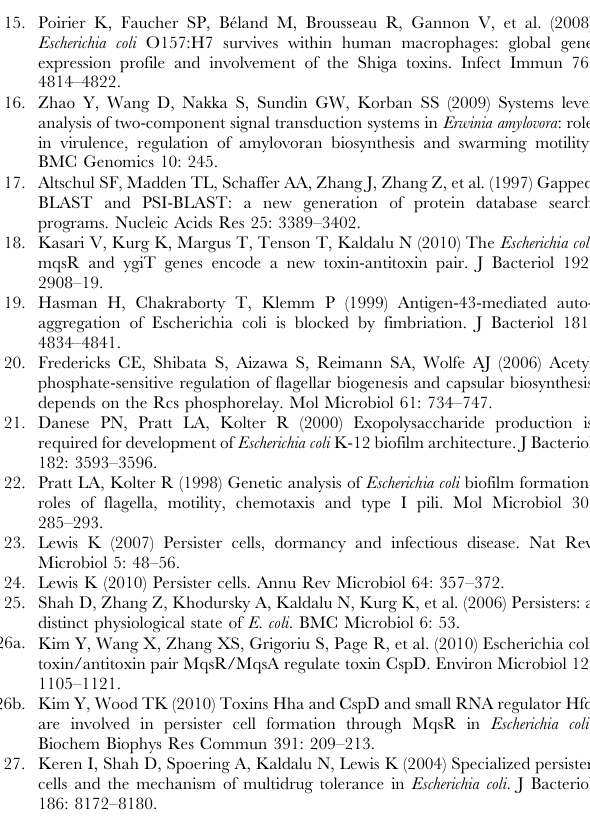
Figure S1 Gene context and protein conservation of ybjN in E. coli , E. amylovora and other related enteric bacteria. Indicate the accession number in GenBank and bacterial strains. Figure S2 Amino acid sequence alignments of YbjN homologs from seven enterobacterial strains. Deduced amino acid sequences have been obtained from NCBI and aligned by ClustalW program (www.ebi.ac.uk/Tools/clustalw2). Identical residues (*), conserved ( : ) and semi-conserved ( . ) substitutions are